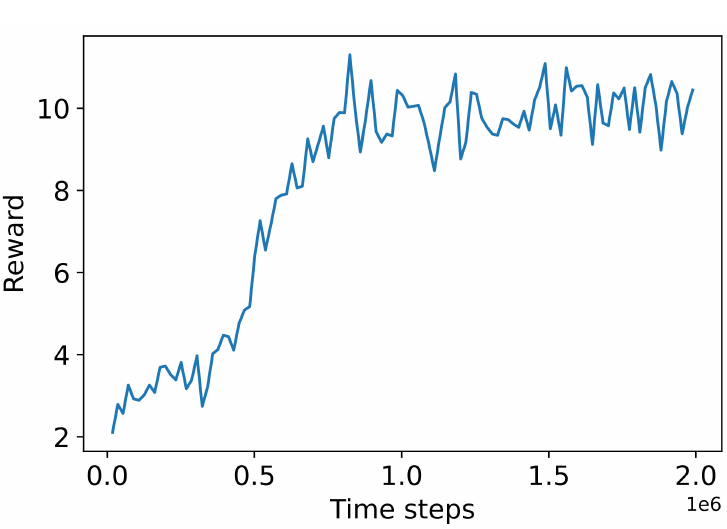
Figure 2. Training progress using the agent parameters determined during hyper-parameter